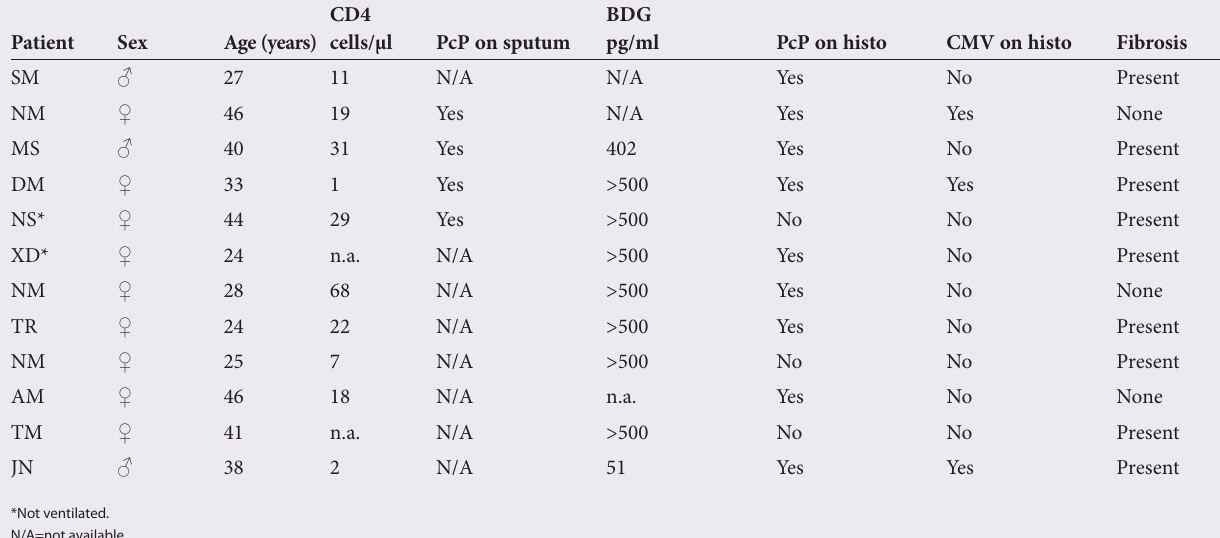
Table 1. Patient demographics and laboratory